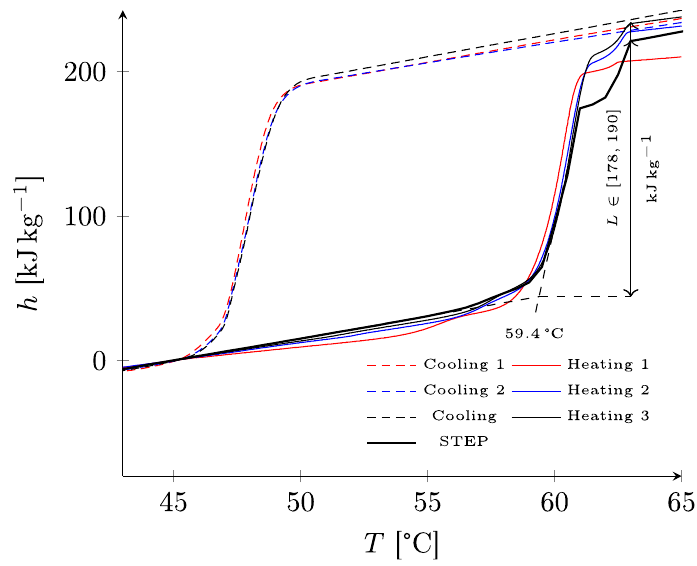
Figure 7. Specific enthalpy of polymer PEG6000 deduced from DSC and STEP experiments.